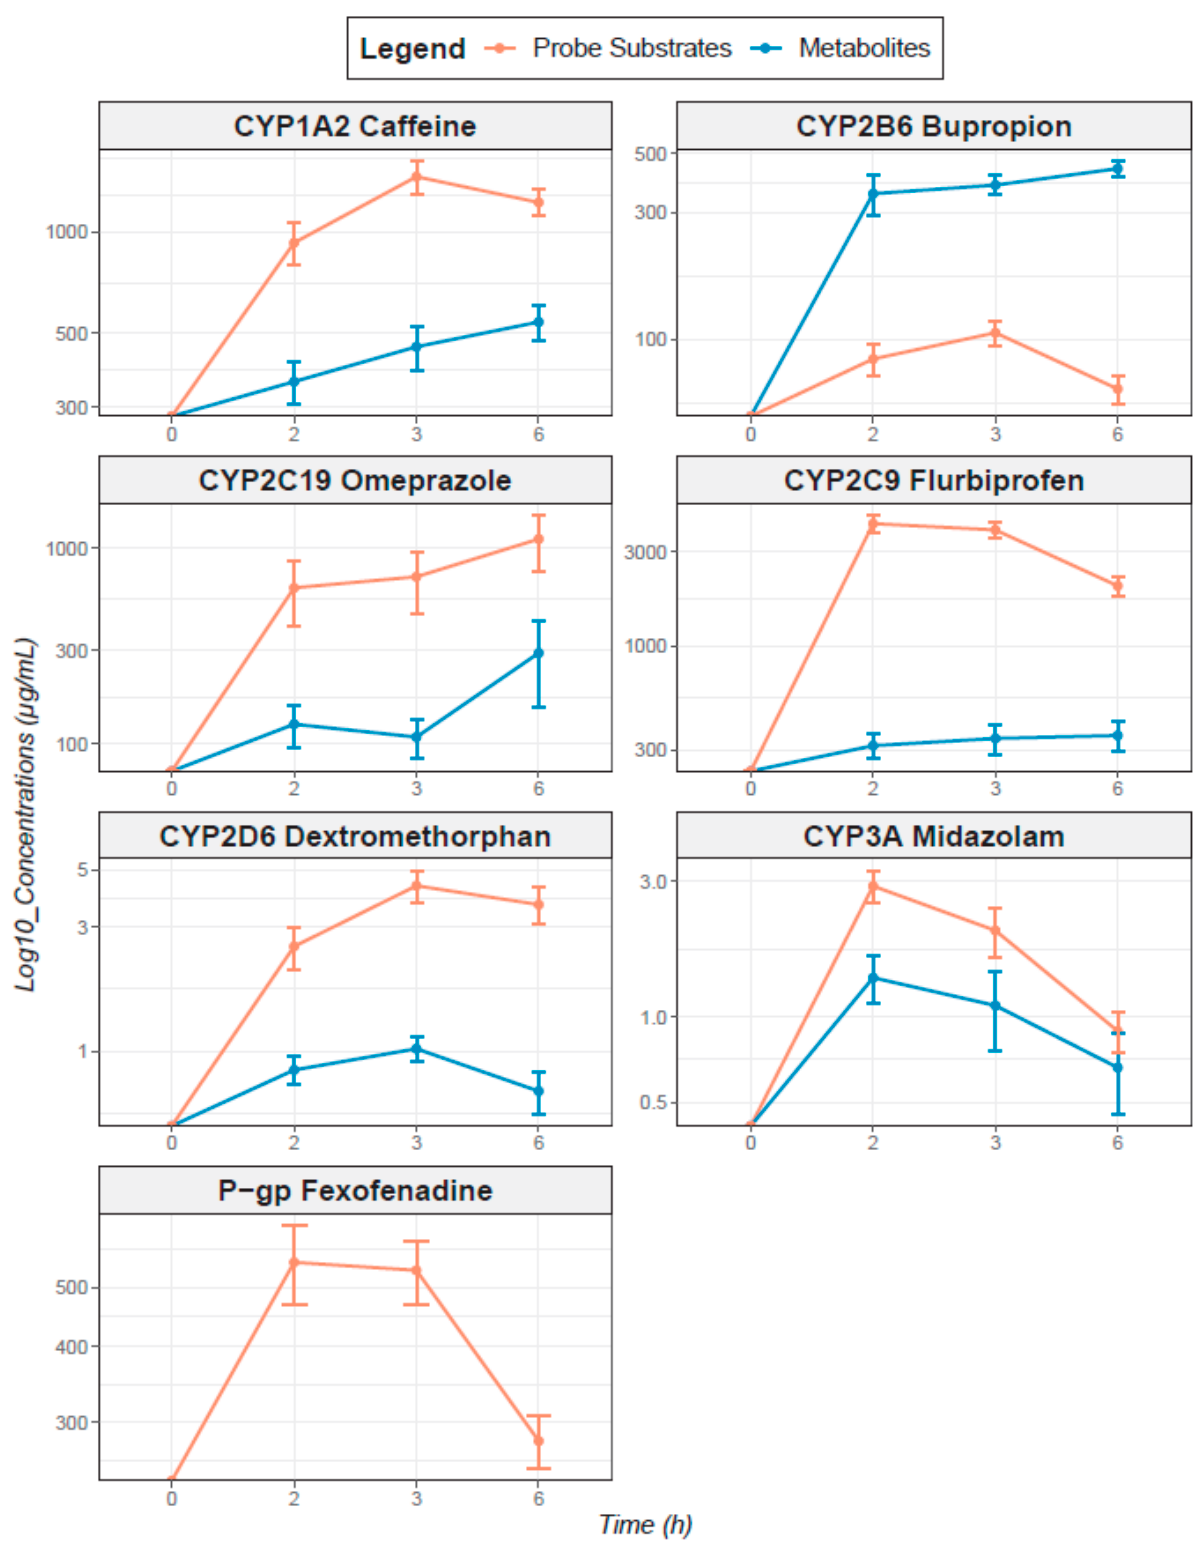
Figure A2. Concentration–time profiles for probe substrates and their CYP450-mediated metabolites after oral administration of phenotyping cocktail probe substrates. Phenotyping cocktail probe substrates are represented in orange and metabolites in blue. Concentrations are on the y axis and represented on a logarithmic scale of base 10; PK profiles represent arithmetic means; error bars represent geometric standard